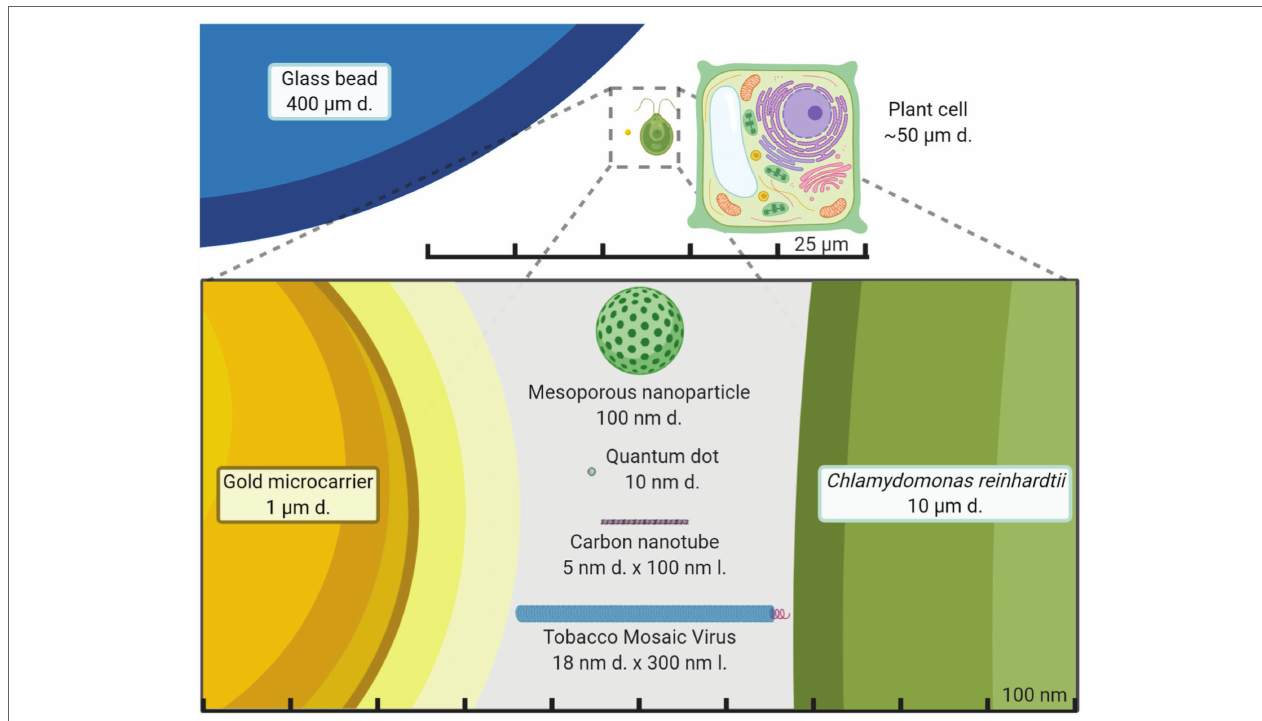
FIGURE 3 | Size comparison of nanomaterials to other exogenous biomolecule delivery systems. Average plant cell and the green alga Chlamydomonas reinhardtii size are compared to chloroplast transformation carriers in the micrometer and nanometer scale. Gold microcarriers are standardly used in chloroplast transformations of both land plants and green algae through particle bombardment while the glass beads are used in a vortex-based protocol for C. reinhardtii . It becomes starkly apparent just how smaller nanoparticles are compared to standard microcarriers and potentially less disruptive for plant cells. The figure is made to